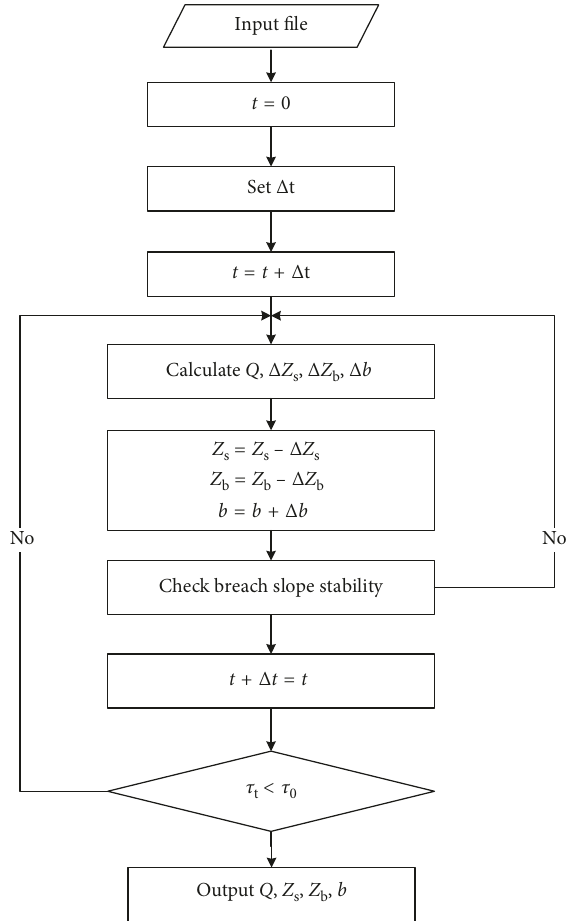
Figure 9: The flow chart of the numerical